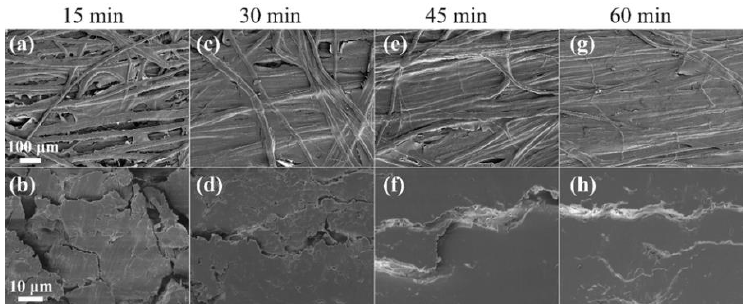
Figure 5. Scanning electron micrographs of the surface ( a , c , e and g ) and cross-section ( b , d , f and h ) of flax-based ACCs after 15, 30, 45 and 60 min of impregnation time at room temperature, respectively.